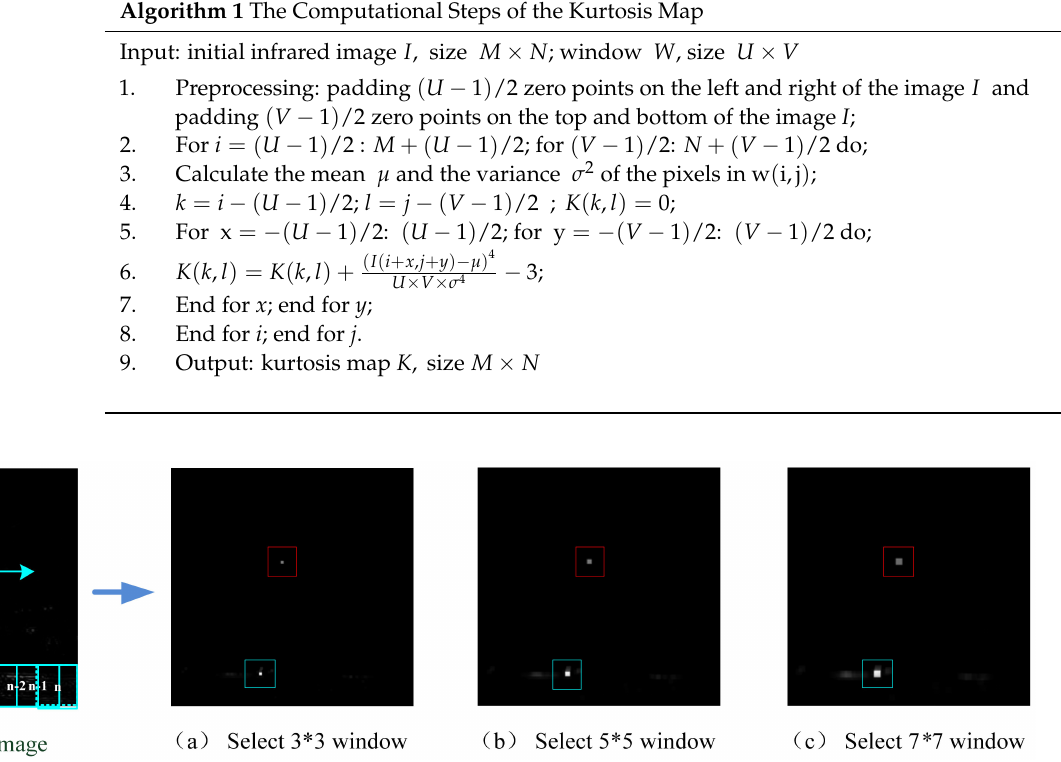
Figure 4. Kurtosis maps calculated by different